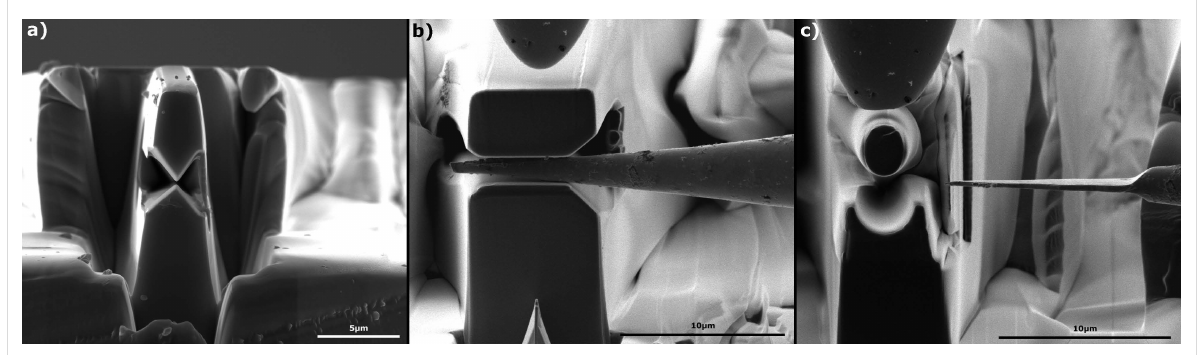
Figure 1: Scanning electron microscope images of different forging tools. Image a) shows a cutting tool, b) a freeforming tool and c) a bending tool.